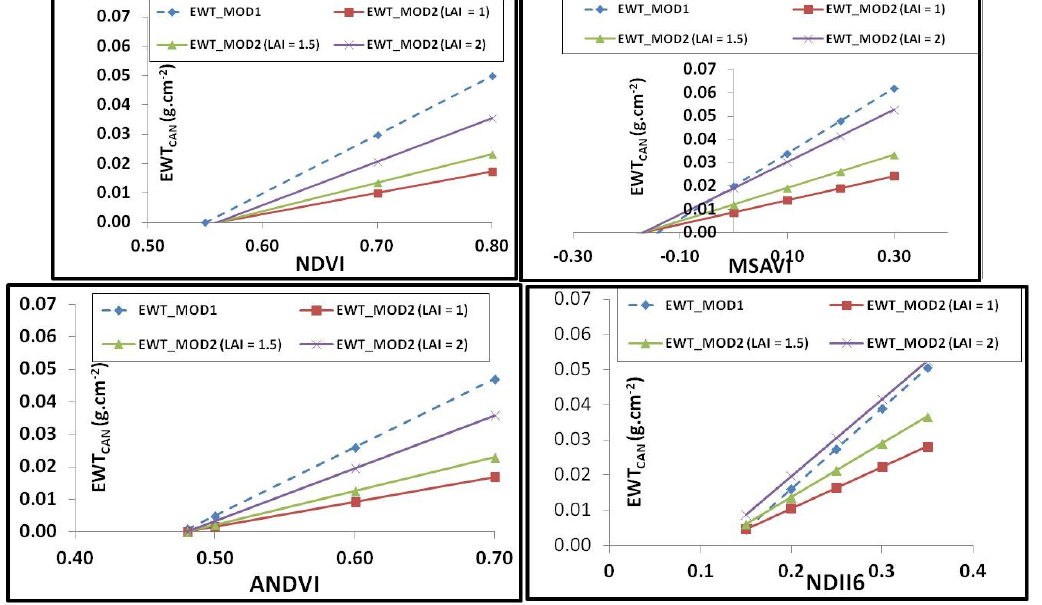
Figure 6. Sparse vegetation effect ( LAI ≤ 2) on EWT CAN inversion models (MOD1, MOD2, R 2 > 0.60) from MODIS-VI (NDVI, MSAVI, ANDVI and NDII6) (note that MSAVI could admit negative